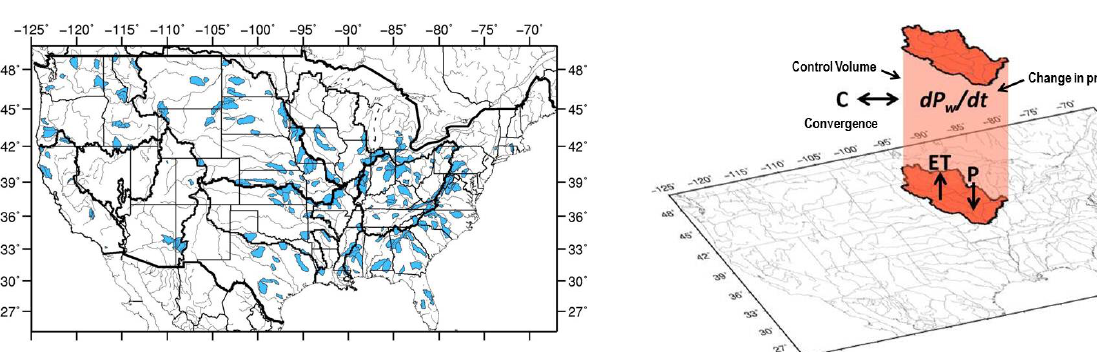
Fig. 3. Example schematic of the Upper Mississippi River Basin components needed to perform an atmospheric water balance to es- timate ET (Eq. 1), including atmospheric moisture convergence, C, change in precipitable water, d P w /d t , and precipitation, P